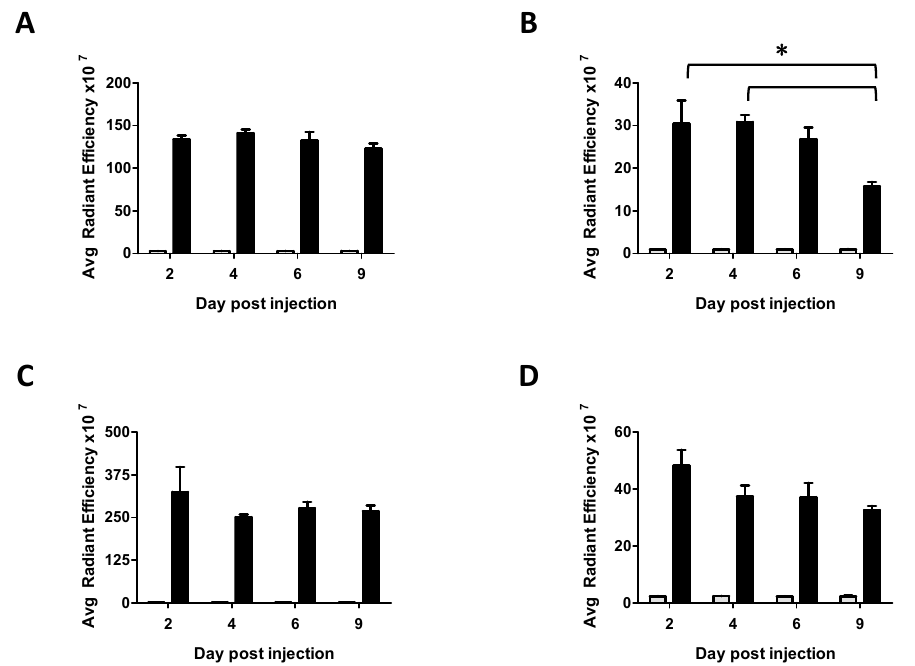
Figure 4. Quantification of the average fluorescence per square centimeter of isolated organs after one IV injection of the ABP-NIR dendrimer using the IVIS (In Vivo Imaging System) Spectrum imaging system. ( A ) Liver. ( B ) Spleen. ( C ) Lungs. ( D ) Kidneys. Grey bars are control mice IV injected with PBS ( n = 3 mice at each time point), black bars are mice IV injected with the ABP-NIR dendrimer ( n = 5 mice at each time point). * p < 0.05 using One Way ANOVA or Kruskal-Wallis’ (for the lungs) tests, followed by post hoc Bonferroni’s and Dunn’s tests, respectively.